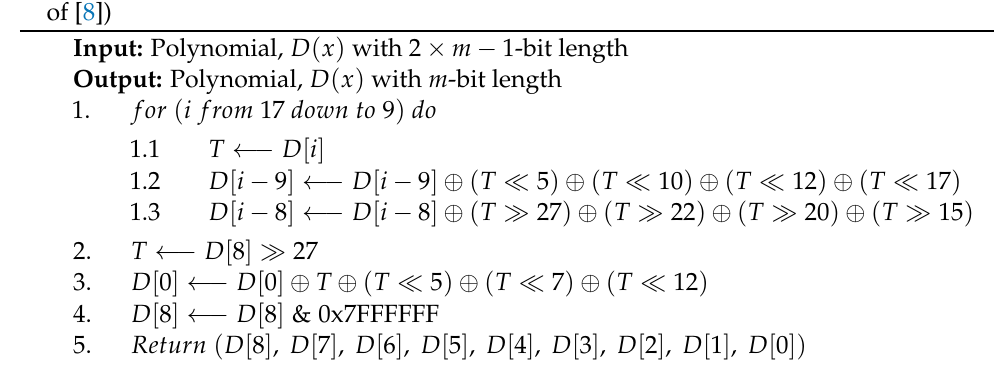
Algorithm A3: Polynomial Reduction Algorithm over GF ( 2 283 ) (algorithm